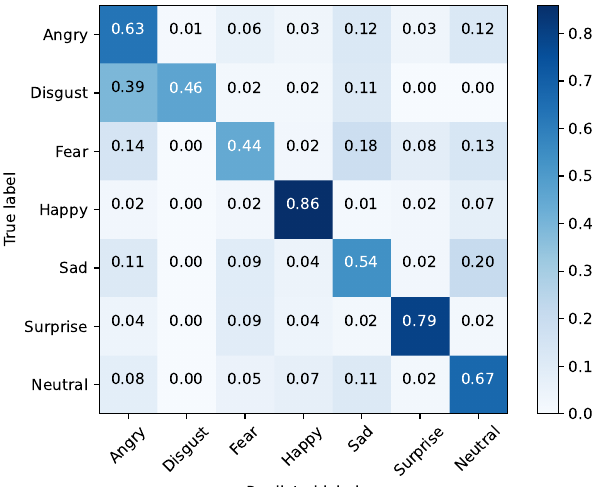
Figure 3. VGG16—training set (FER2013).